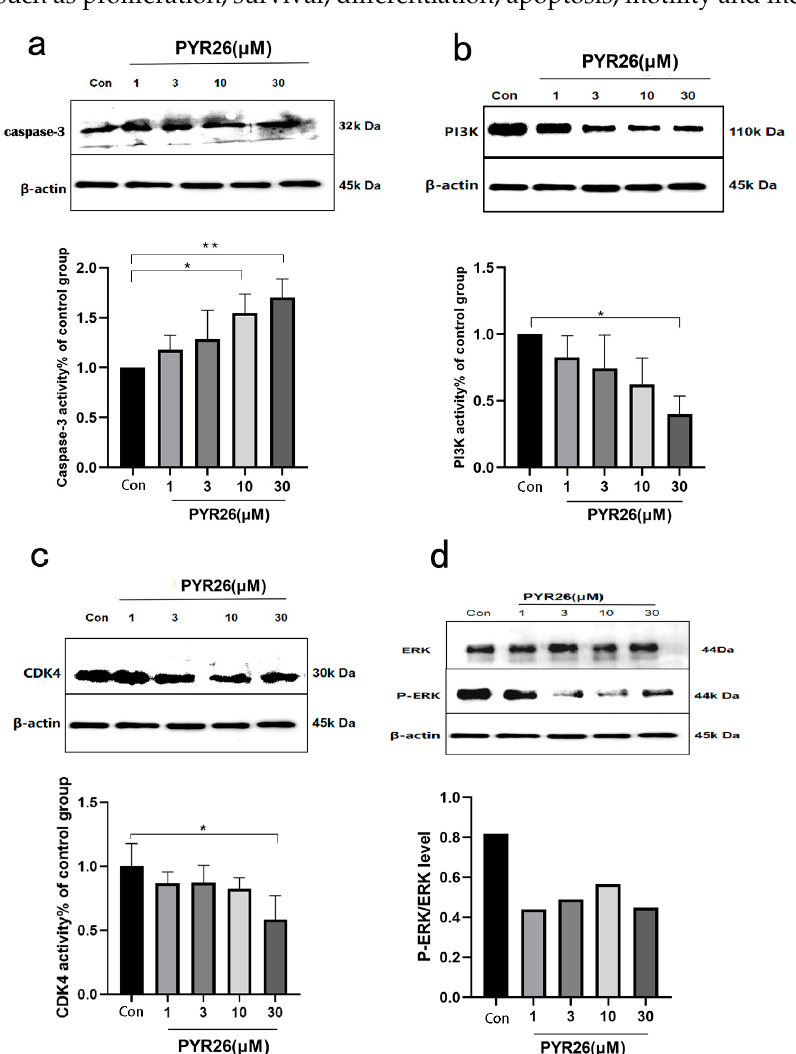
Figure 6. Effect of PYR26 on the expression of caspase-3, PI3K, CDK4 and p-ERK proteins in HepG2 cells after 24 h administration. ( a ) Western blot analysis showed that the levels of caspase-3 were increased by PYR26; ( b ) Western blot analysis showed that the levels of PI3K were inhibited by PYR26; ( c ) Western blot analysis showed that the levels of CDK4 were inhibited by PYR26; ( d ) Western blot analysis showed that the levels of ERK were inhibited by PYR26 (* p < 0.05, ** p < 0.01 vs. control group).